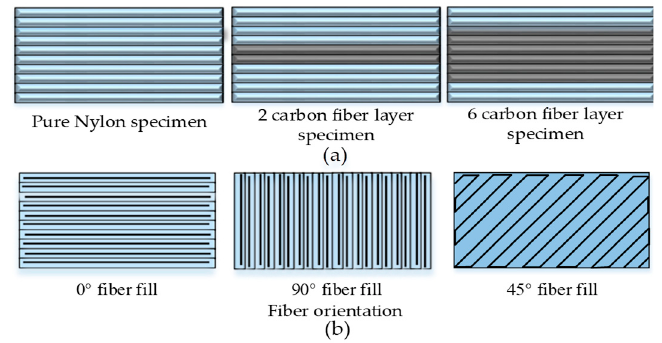
Figure 12. Illustration of two build strategies for FFF with two nozzles setups: ( a ) number and placement of carbon fibers in polymer matrix [59]; and ( b ) illustration of fiber fill orientation.